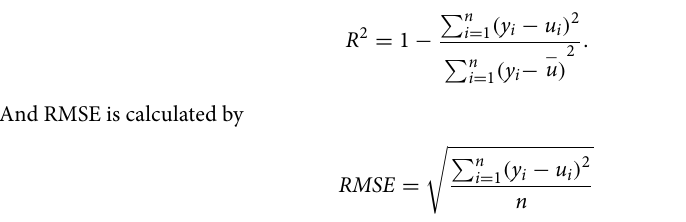
Algorithm evaluation. Models built by different algorithms and descriptor subsets were evaluated by R 2 and RMSE. R 2 computes the coefficient of determination. It is calculated by